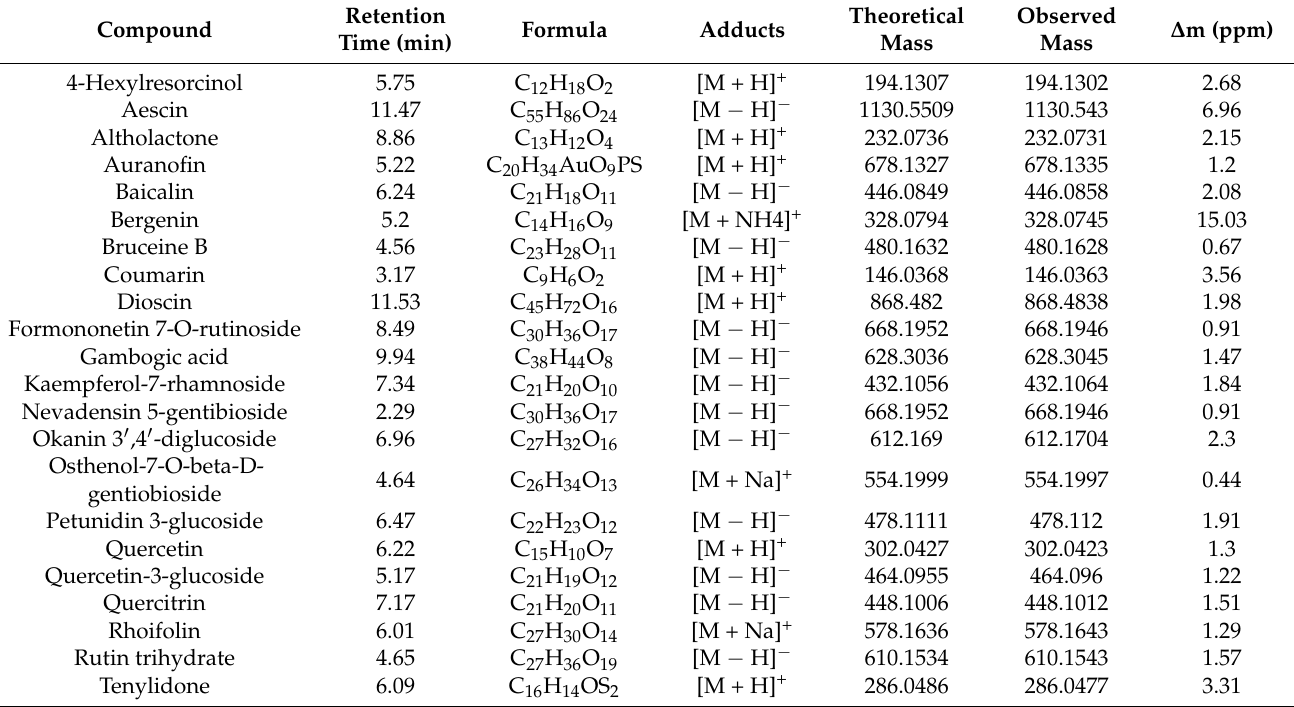
Table 2. Putative identification of secondary metabolites with known anti-inflammatory activitiy in switchgrass through untargeted metabolomics analyses.